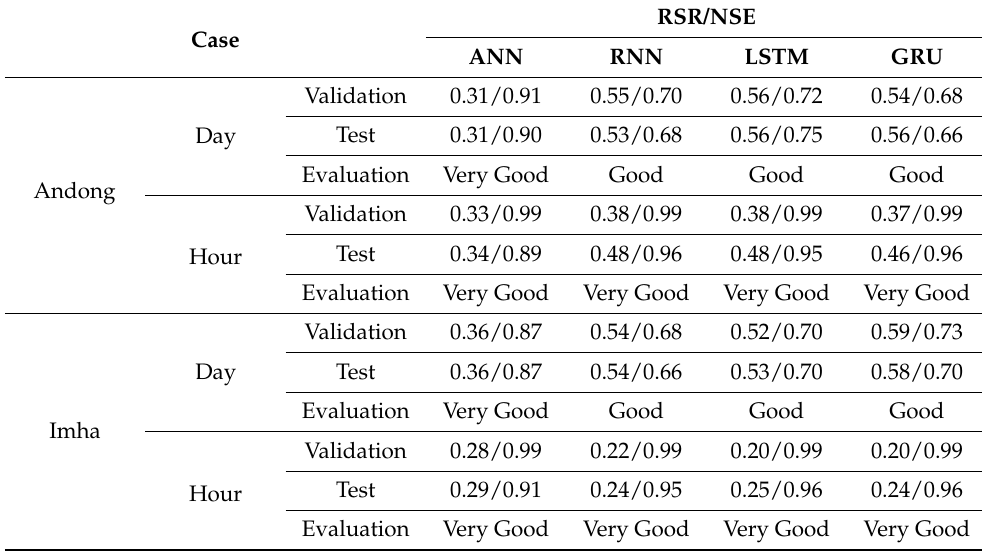
Table 6. Performance rating evaluation for selected